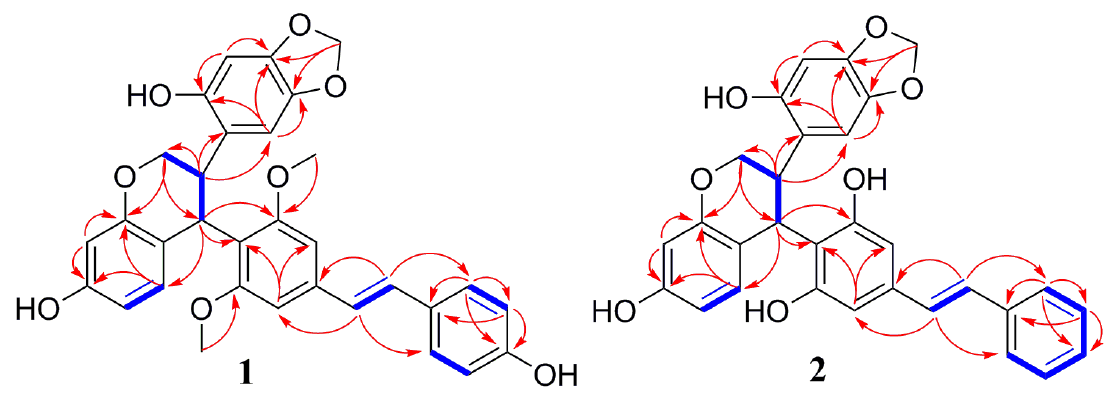
Figure 2. Key 1 H– 1 H COSY ( – ) and HMBC ( → ) correlations of 1 and 2 Figure 2. Key 1 H – 1 H COSY ( ─ ) and HMBC ( → ) correlations of 1 and 2 .